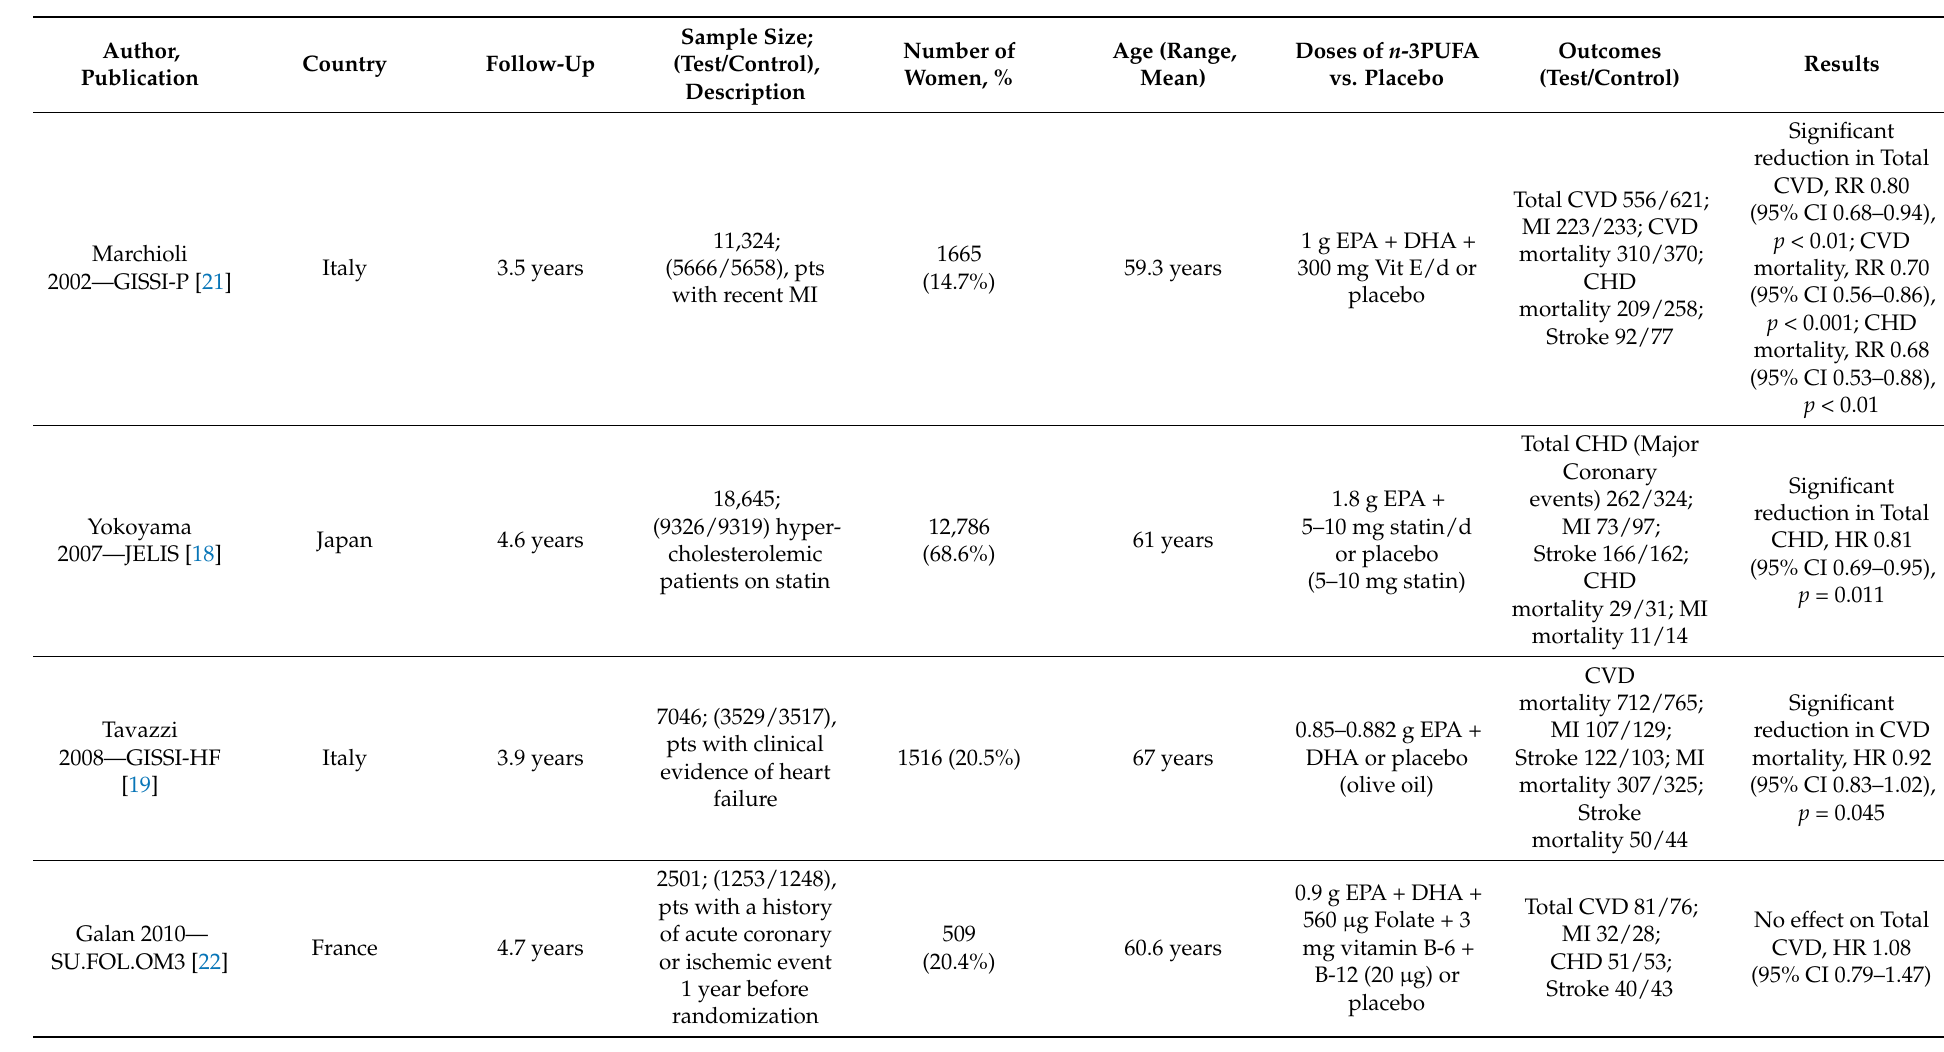
Table 1. Characteristics of RCTs examining the effects of n -3 PUFA on CVD and CVD-related